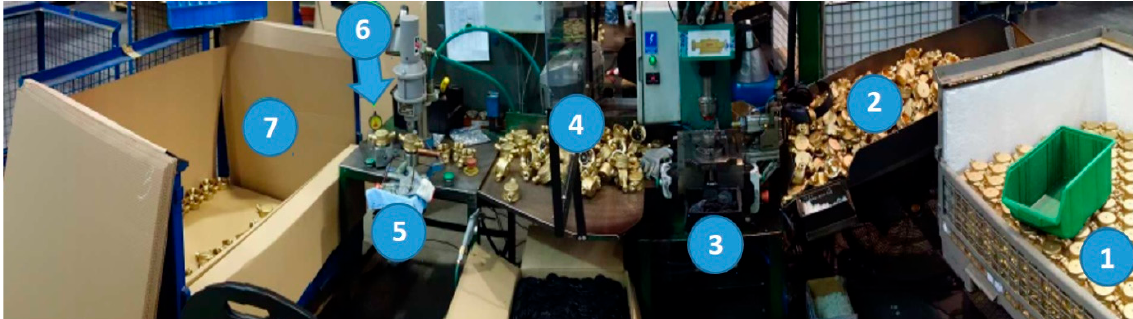
Figure 2. Assembly line for water meter bodies with elements: 1—Storage bay with a basket of processed water meter bodies intended for assembly components, 2—Auxiliary tray for machined bodies, 3—Station for assembling the strainer and damming plate in the water meter body, 4—Transitional storage bay for partially assembled bodies, 5—Station for mounting the axle in the water meter body, 6—Control of the depth of the axle seating in the water meter body, 7—Storage bay with a basket for the assembled water meter bodies.